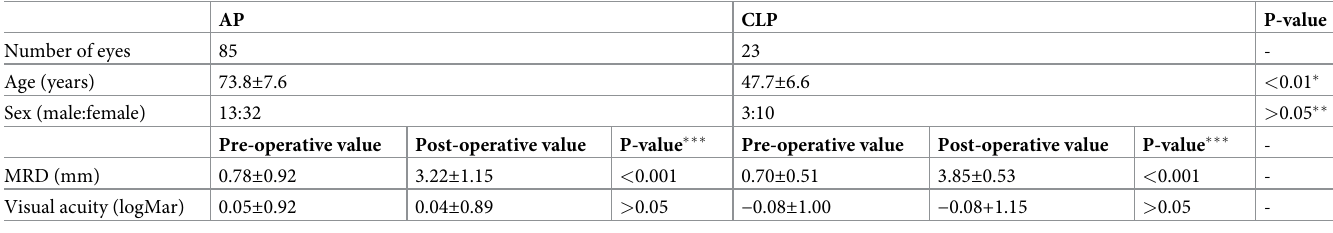
Table 1. Demographic data of the age-related ptosis (AP) and contact lens-related ptosis (CLP) groups. AP CLP